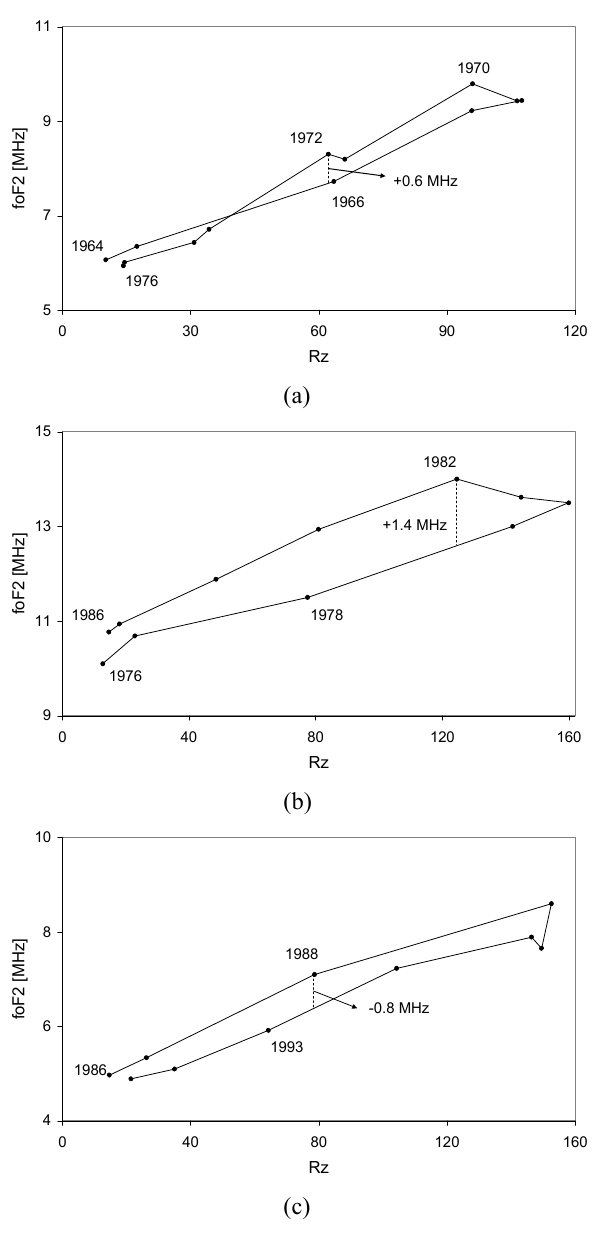
Figure 1. Monthly median foF2 at noon in terms of Rz for (a) Mundaring in September Fig. 1. Monthly median fo F2 at noon in terms of R z for (a) Mundar- during solar cycle 20 (b) Ahmadabad in April during solar cycle 21 and (c) Argentine ing in September during solar cycle 20 (b) Ahmadabad in April dur- Islands in April during solar cycle 22. The vertical dashed line indicate the maximum ing solar cycle 21 and (c) Argentine Islands in April during solar amplitude of the hysteresis which is given in MHz. cycle 22. The vertical dashed line indicate the maximum amplitude of the hysteresis which is given in MHz.